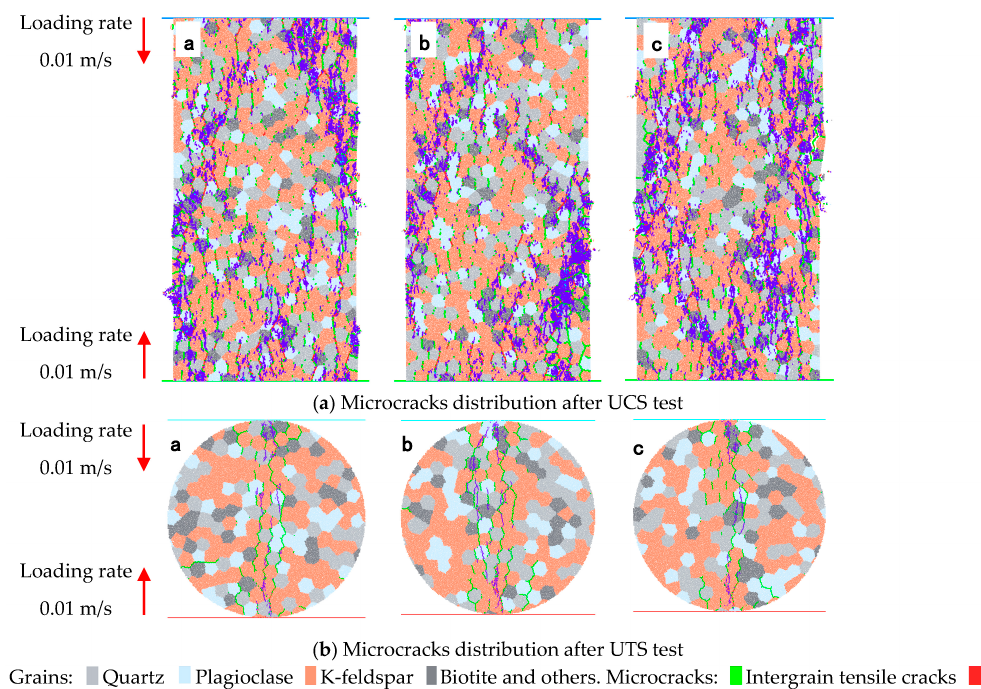
Figure 10. Mineral distributions and microcrack distributions in rock models after UCS and UTS tests under the loading rate of 0.01 m/s. a, b, c are the indexes of samples, respectively. ( a ) Microcracks distribution after UCS test; ( b ) Microcracks distribution after UTS test.